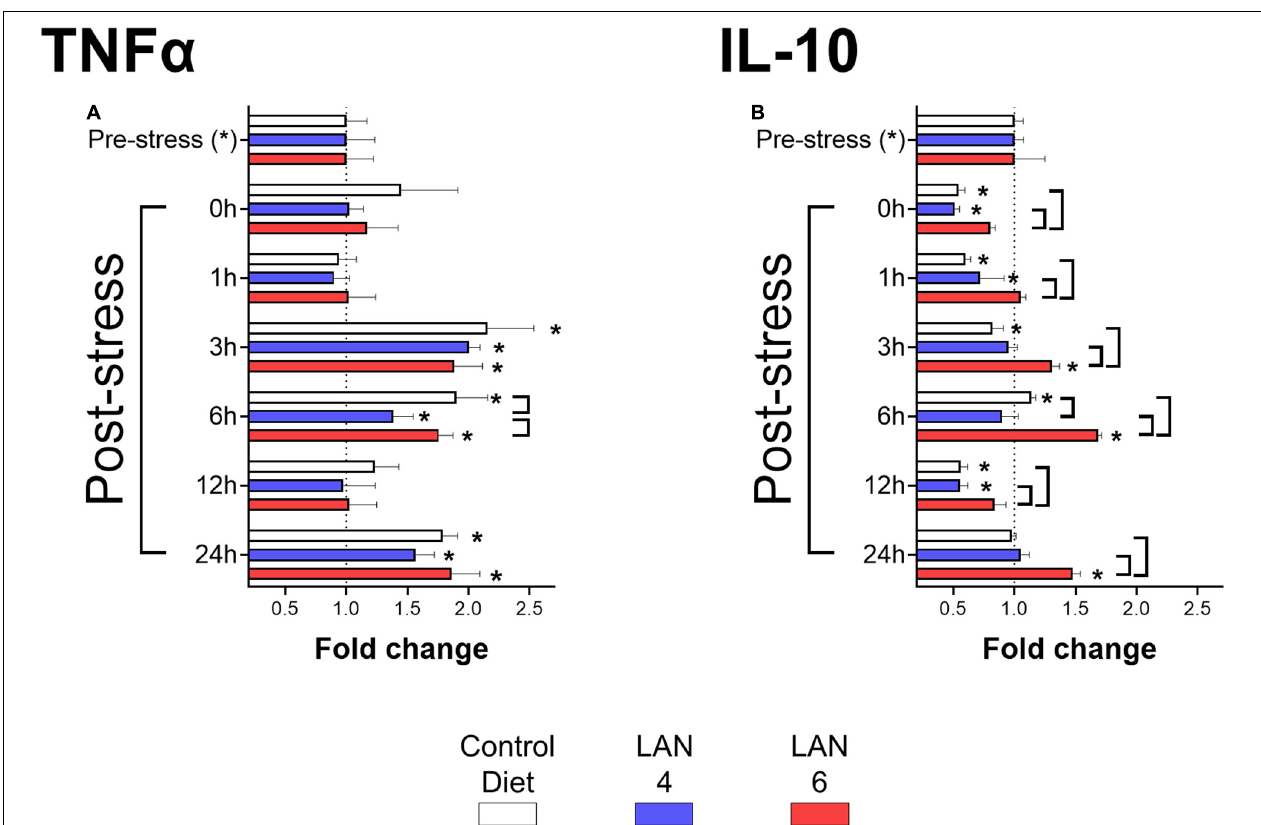
FIGURE 2 | Immunological biomarkers in plasma of Atlantic salmon exposed to acute hypoxia stress. Sampling times: pre-stress, 0 h (immediately after stress), 1, 3, 6, 12, and 24 h post-stress. In white: CD. In blue: LAN4. In red: LAN6. Each bar: n = 4. *: Significant differences ( p < 0.05) compared with pre-stress group (from each diet). Bracket: significant differences ( p < 0.05) between dietary groups at the same sampling time (CD, LAN4, and LAN6, respectively). (A) TNF α . (B) IL-10. (A,B) Data obtained from ELISA are expressed as fold change related to the pre-stress group of each